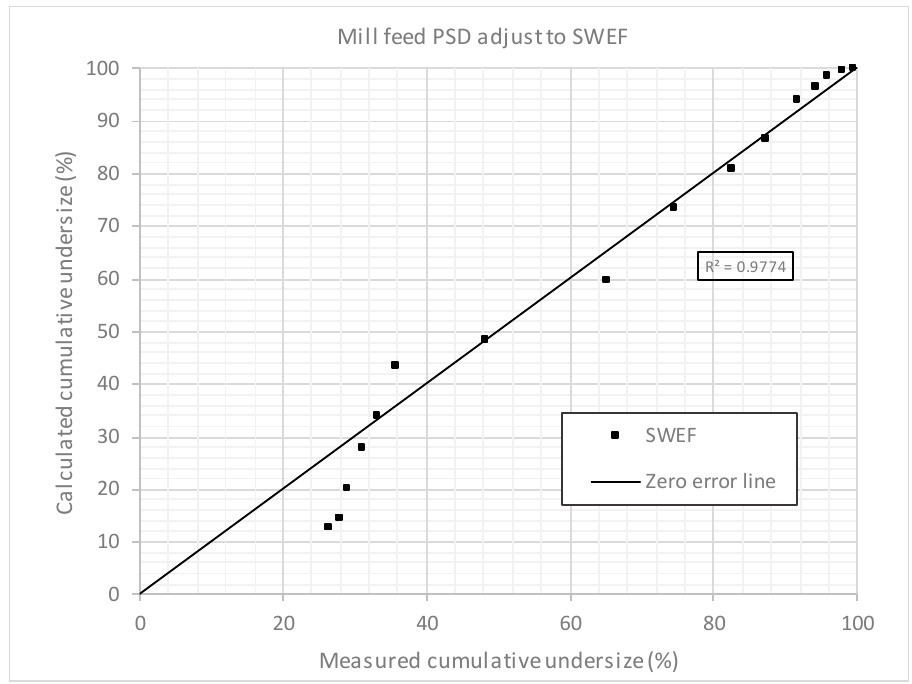
Figure 2. Zero error graph for the SWEF.